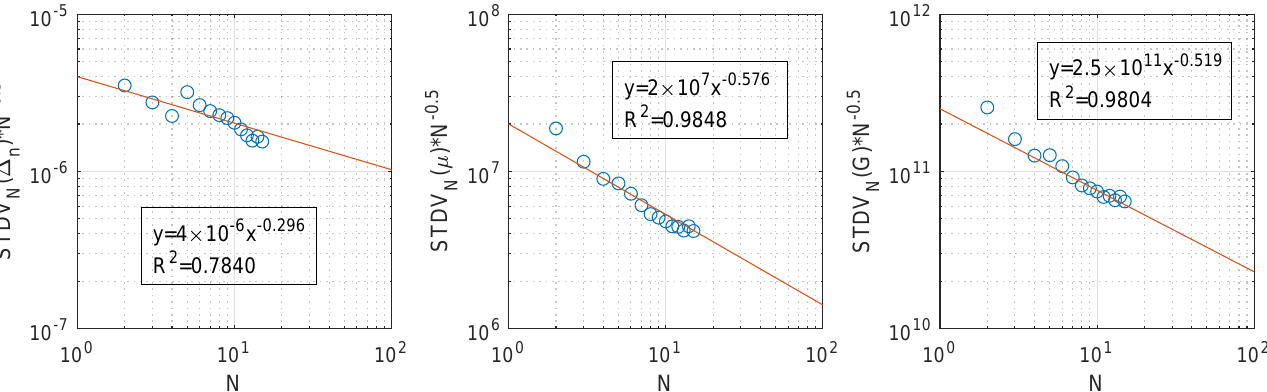
Figure 15. Standard deviation of the growing population N from 1 to 15 divided by the root square of the sampled population N (Blue circles). Power trend line (red line). Trend line equation and R 2 are presented with y representing the vertical axis ( STDV N ( var . ) / N 0.5 ) and x the horizontal axis ( N )